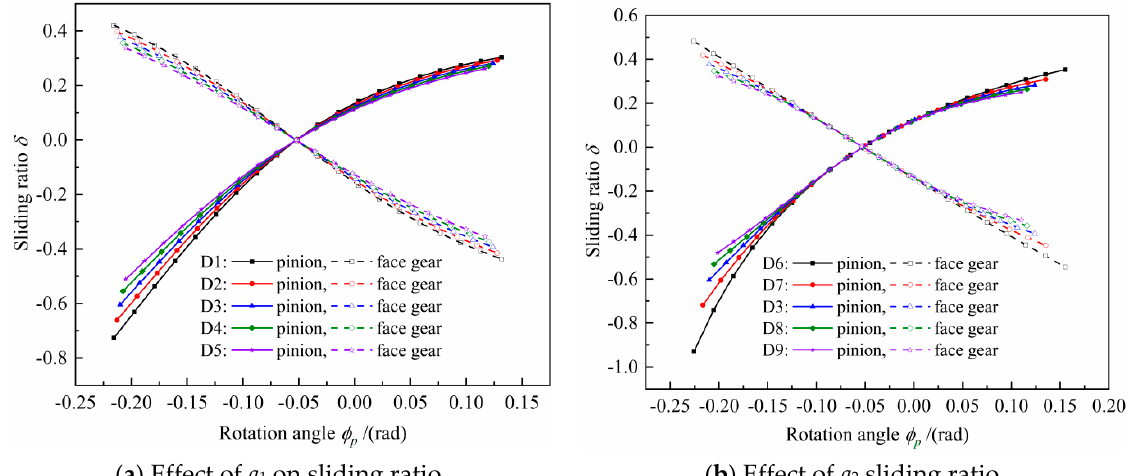
Figure 9. Effect of a 1 and a 2 on sliding ratio.